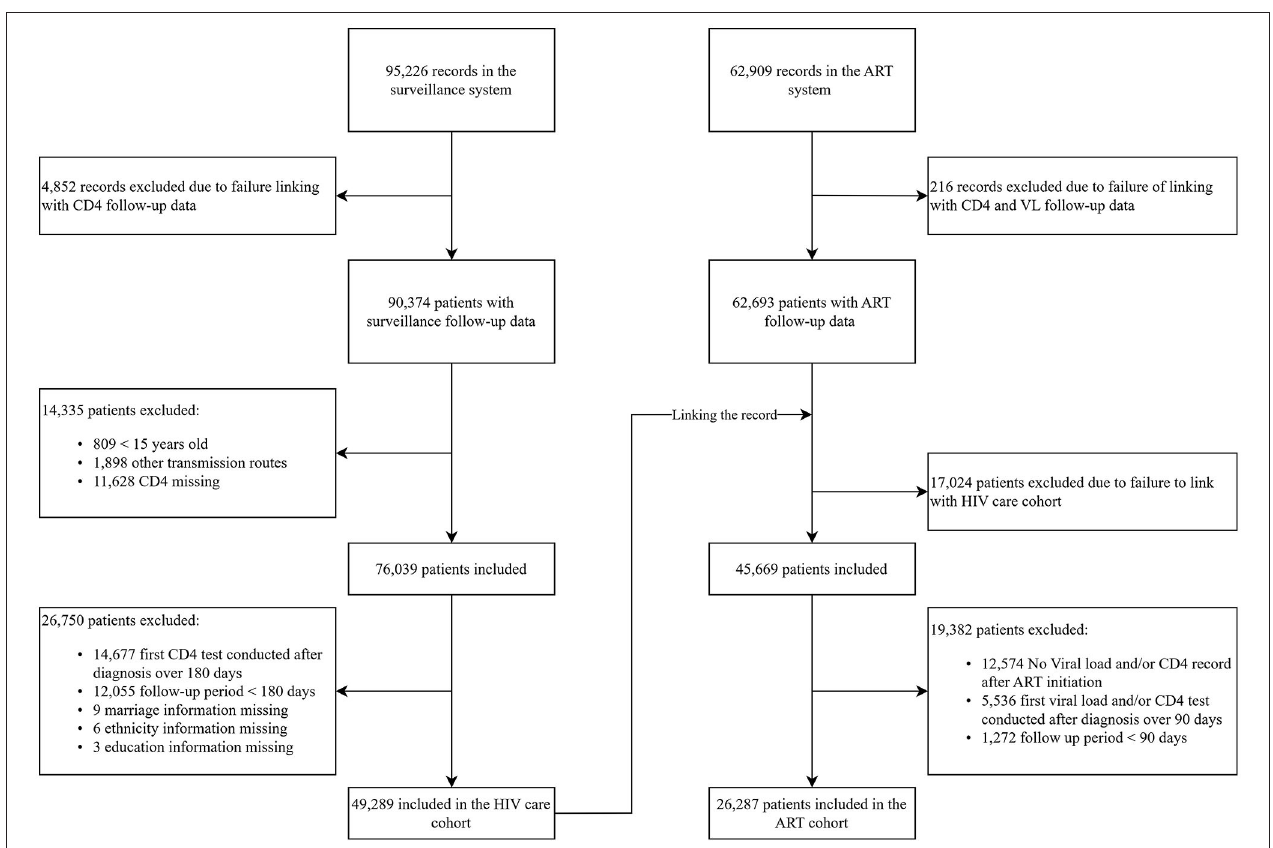
FIGURE 1 | Flowchart showing the design of surveillance and the antiretroviral therapy (ART) cohort.